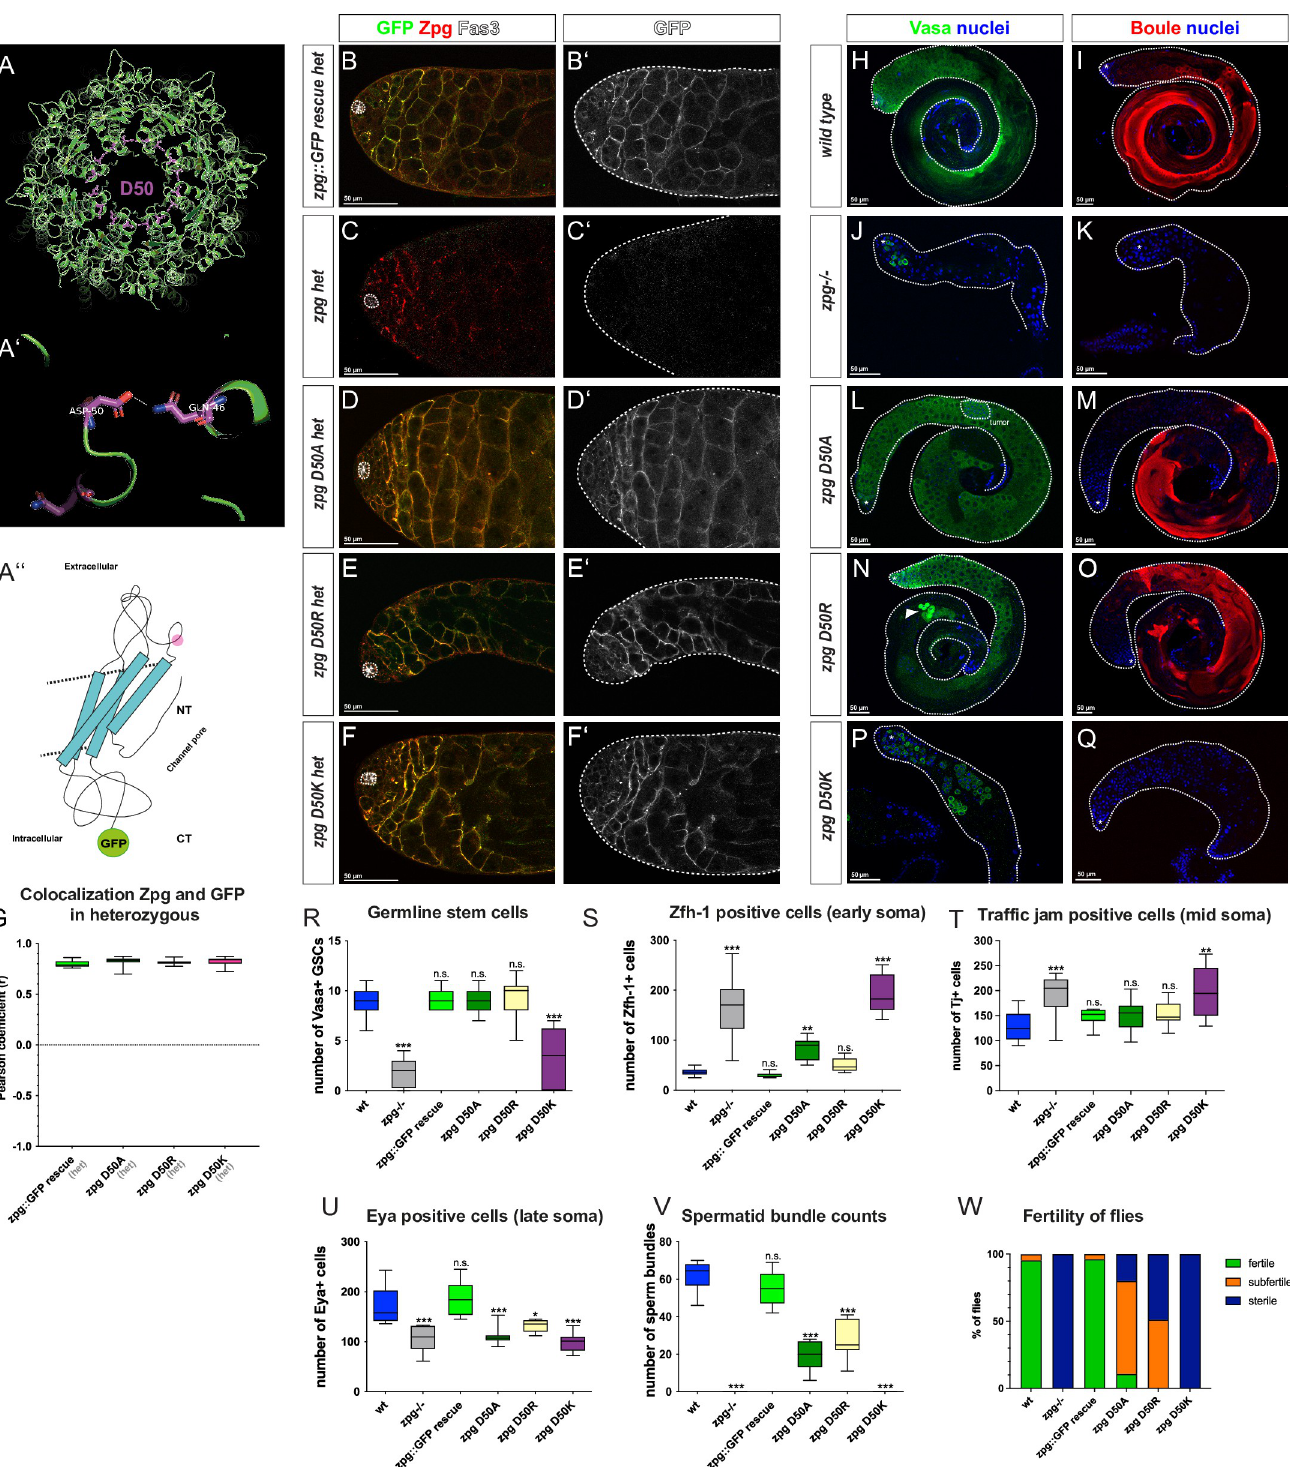
Fig 5. Mutations in the Zpg D50 channel pore residue result in germ cell differentiation defects. (A) Homology model of Zpg showing the position of aspartate 50 (D50) within the channel pore. (A’) D50 is predicted to form a hydrogen bond with glutamine 49 (Q49) of the adjacent Zpg subunit. (A”’) Simplified model highlighting the location of D50 (marked in pink) in the first extracellular loop. (B-F) Colocalization of wildtype endogenous Zpg and GFP-tagged, mutated Zpg. Flies heterozygous for a null allele of zpg but also containing one copy of the wildtype genomic zpg rescue construct ( zpg GFP::GR; B-B’), no rescue construct (C-C’),